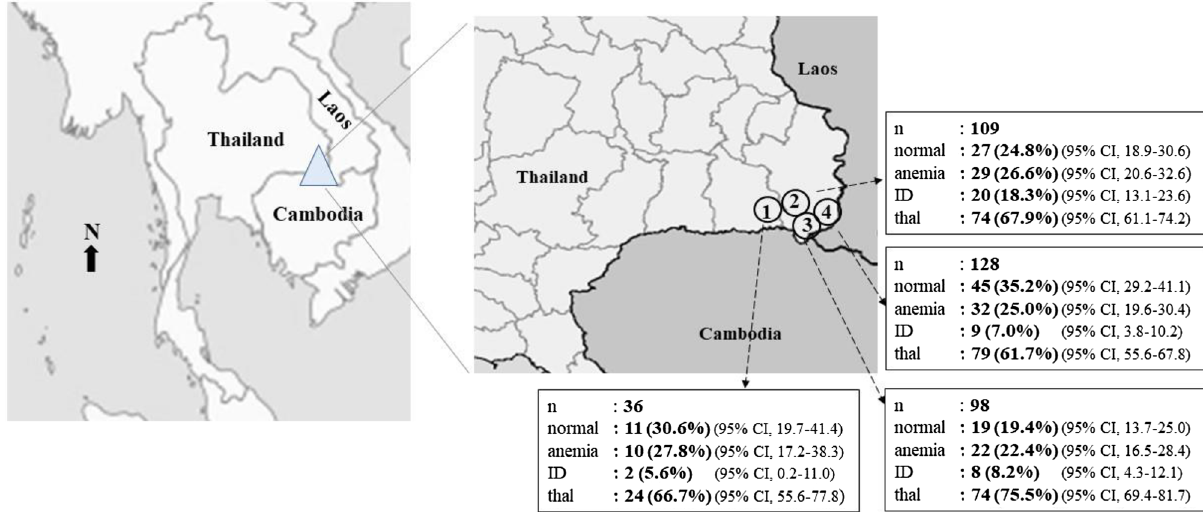
Figure 1. Map of Thailand, Lao PDR and Cambodia illustrating four districts at the Thailand-Lao PDR- Cambodia triangle where 371 specimens were recruited. ① , ② , ③ , and ④ indicated Kantharalak, Nam Khun, Nam Yuen, and Na Chaluai districts, respectively. The prevalence of anemia, iron deficiency (ID), and thalassemia (thal) in each area were summarized in the corresponding box. Normal indicated subjects who had no anemia, ID and